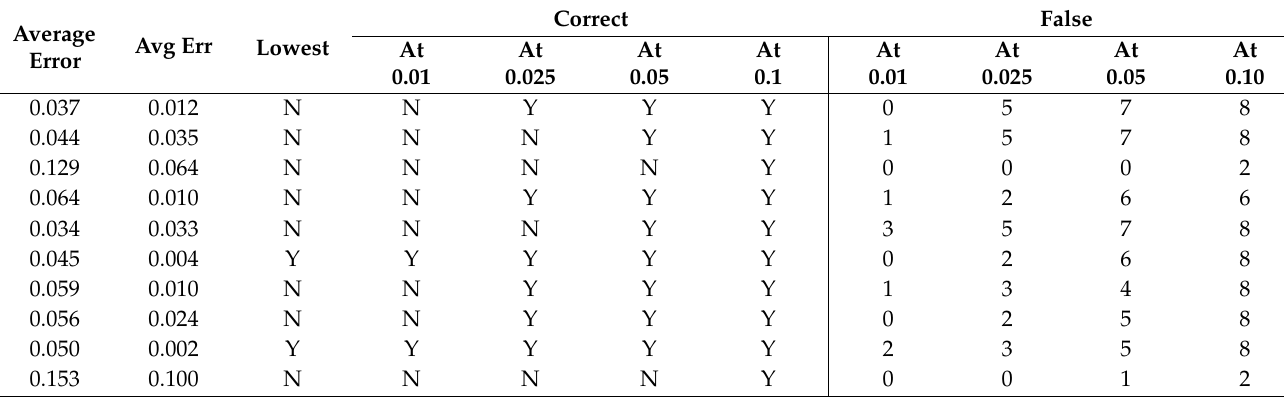
Table 1. Set 1, trials 1–10 summary data (single 0.5 PR value).